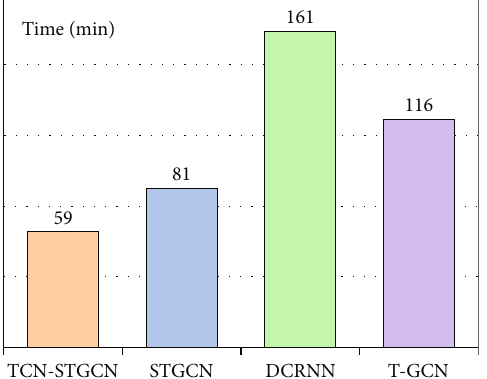
Figure 12: Comparison results of calculation time of di ff erent